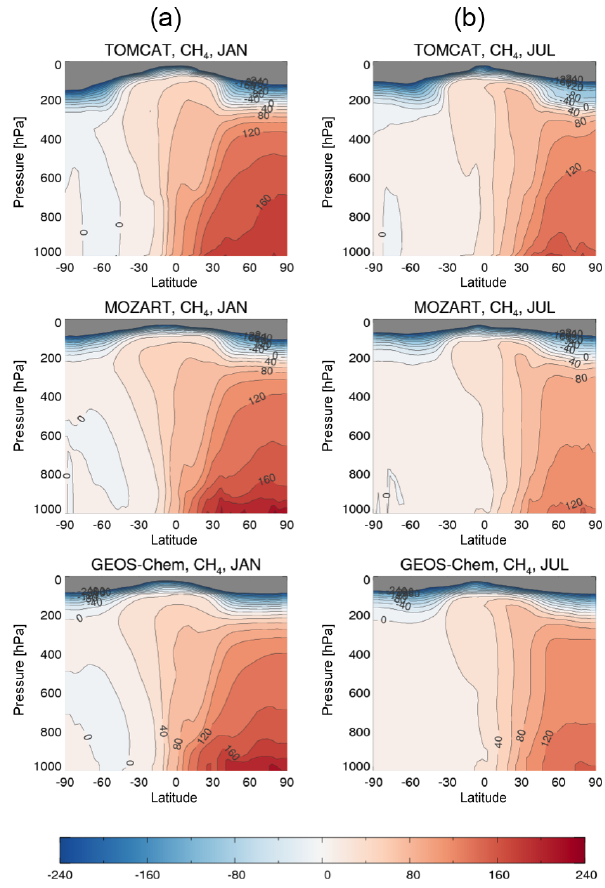
Figure 11. Zonal-mean distribution of CH 4 (ppb) for January (a) and July (b) 2011 in each of the GAUGE CTMs. For each model the concentration of CH 4 at the surface South Pole concentration is subtracted from the global